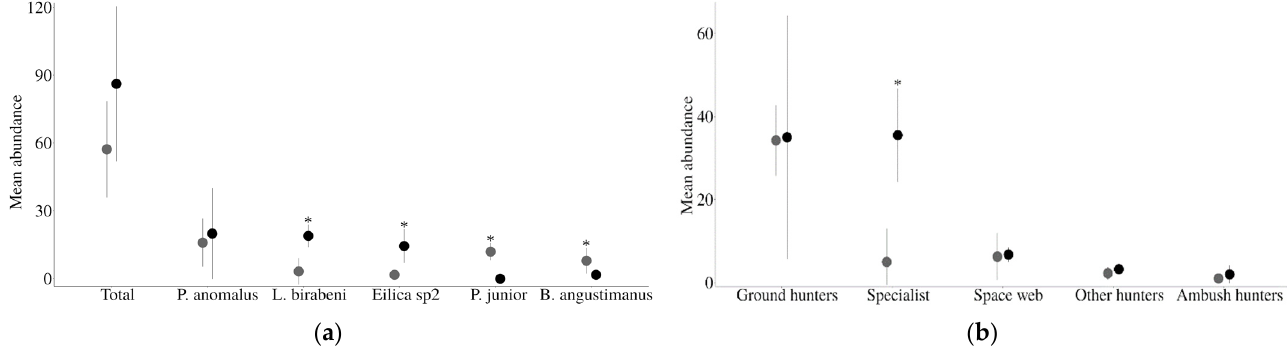
Figure 4. Mean abundance per site (±standard error) of the total arachnids and main taxa ( a ), and more abundant arachnid guilds ( b ). Asterisk symbol indicates significant differences in abundances. Black symbols represent unburned sites; grey symbols represent burned sites.